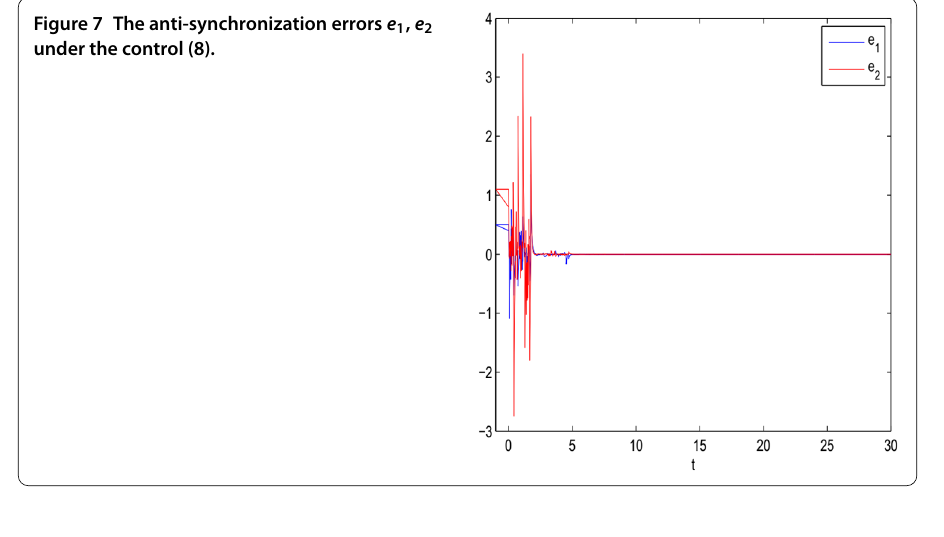
Figure 8 The chaotic attractor of system (18) and